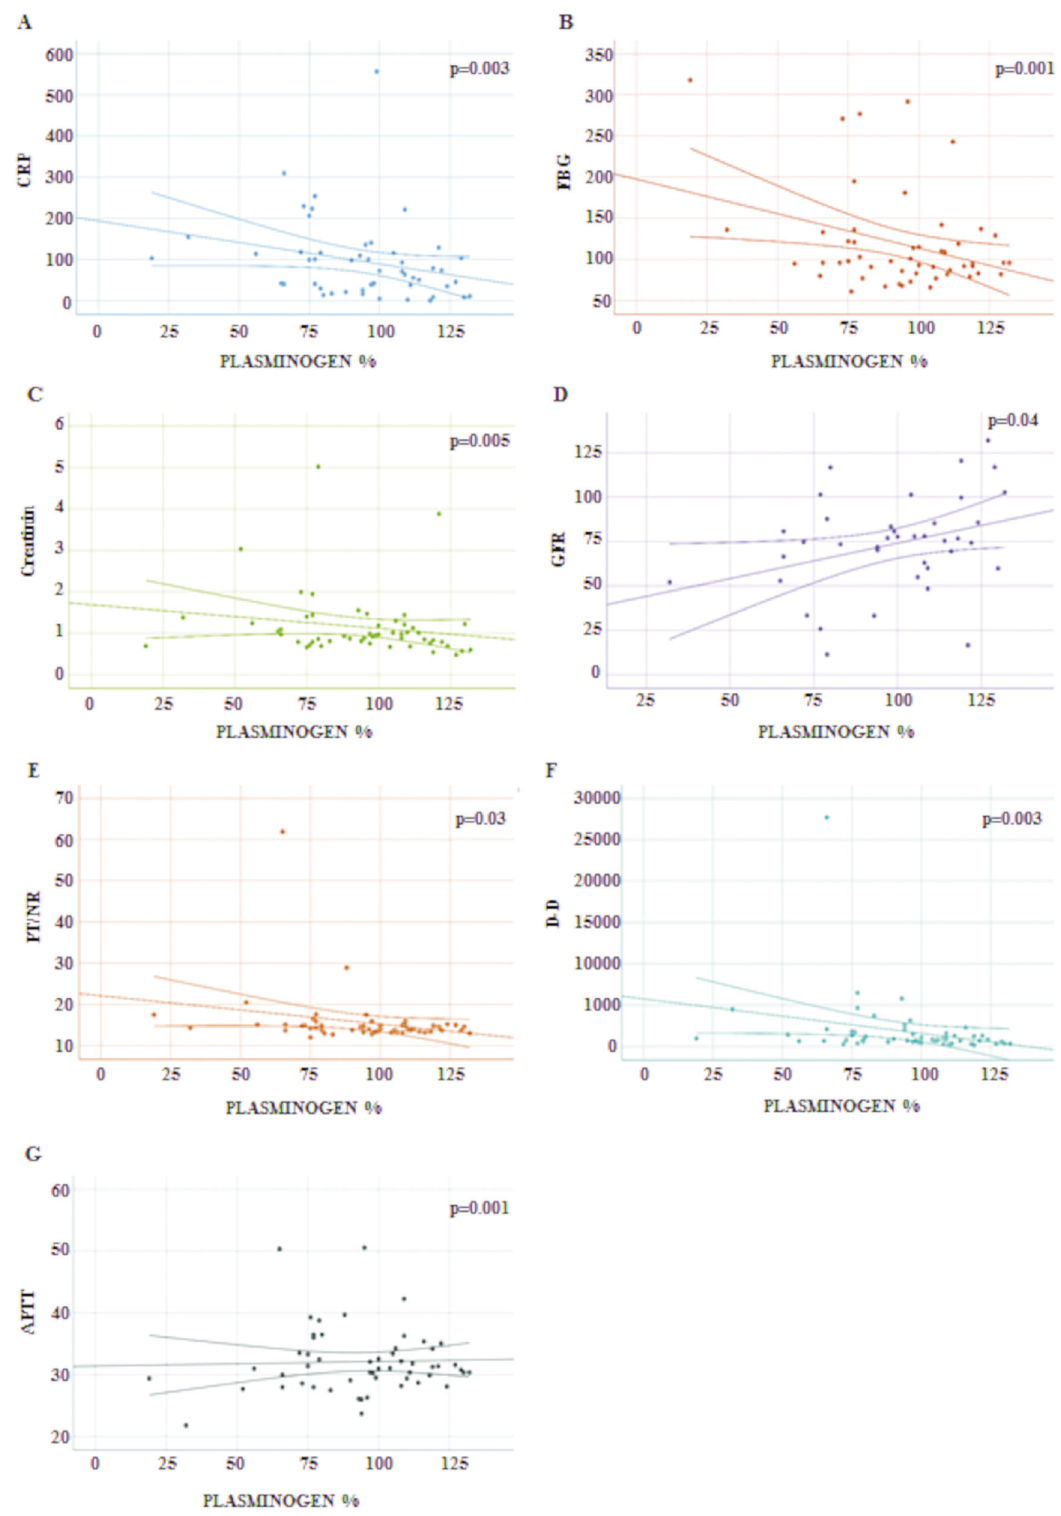
Fig. 1 Analysis of the correlation between level of plasminogen and markers related to COVID-9 pathogenesis. Levels of plasminogen were correlated with several markers linked with COVID-19 pathogenesis such as CRP ( A ), FBG ( B ), creatinine ( C ), GFR ( D ), PT/INR ( E ), D-D ( F ), and APTT ( G ). CRP C reactive protein, FBG fasting blood glucose, GFR glomerular fi ltration rate, PT/INR prothrombin time and international normalized ratio, D-D D-dimer, APTT activated partial thromboplastin time.